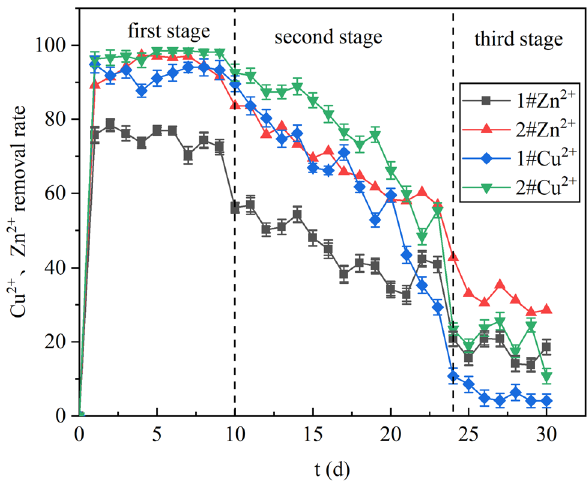
Figure 6. Cu 2+ and Zn 2+ removal effects in dynamic columns 1# and